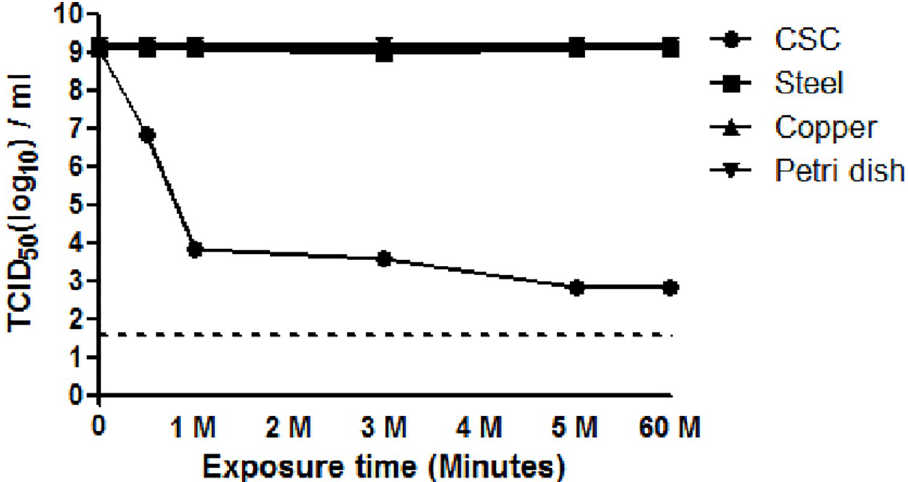
Fig 1. Effect of CSC on the infectivity of hCoV 229E was exposed to CSC surface and the samples were collected at each time point and titrated in MRC-5 cells. The results shown are representative of duplicates. Control groups (steel, copper and sterile polystyrene) were treated identically at each time point. Samples were titrated in MRC-5 cells using four replicates. The dotted line denotes the limit of detection of the assay.